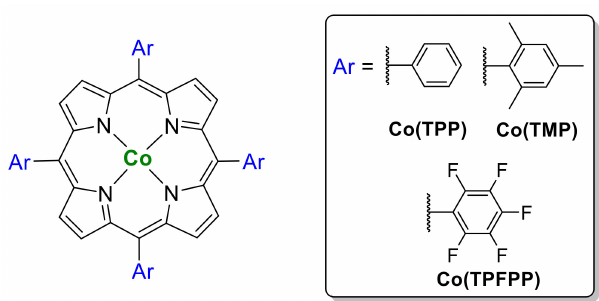
Figure 15. Cobalt(II) complexes used in the intramolecular ring-closing C-H bond amination study: cobalt(II) meso -tetraphenylporphyrin Co(TPP) ; cobalt(II) meso -tetrakis(pentafluorophenyl)porphyrin Co(TPFPP) ; cobalt(II) meso -tetramesitylporphyrin Co(TMP) .